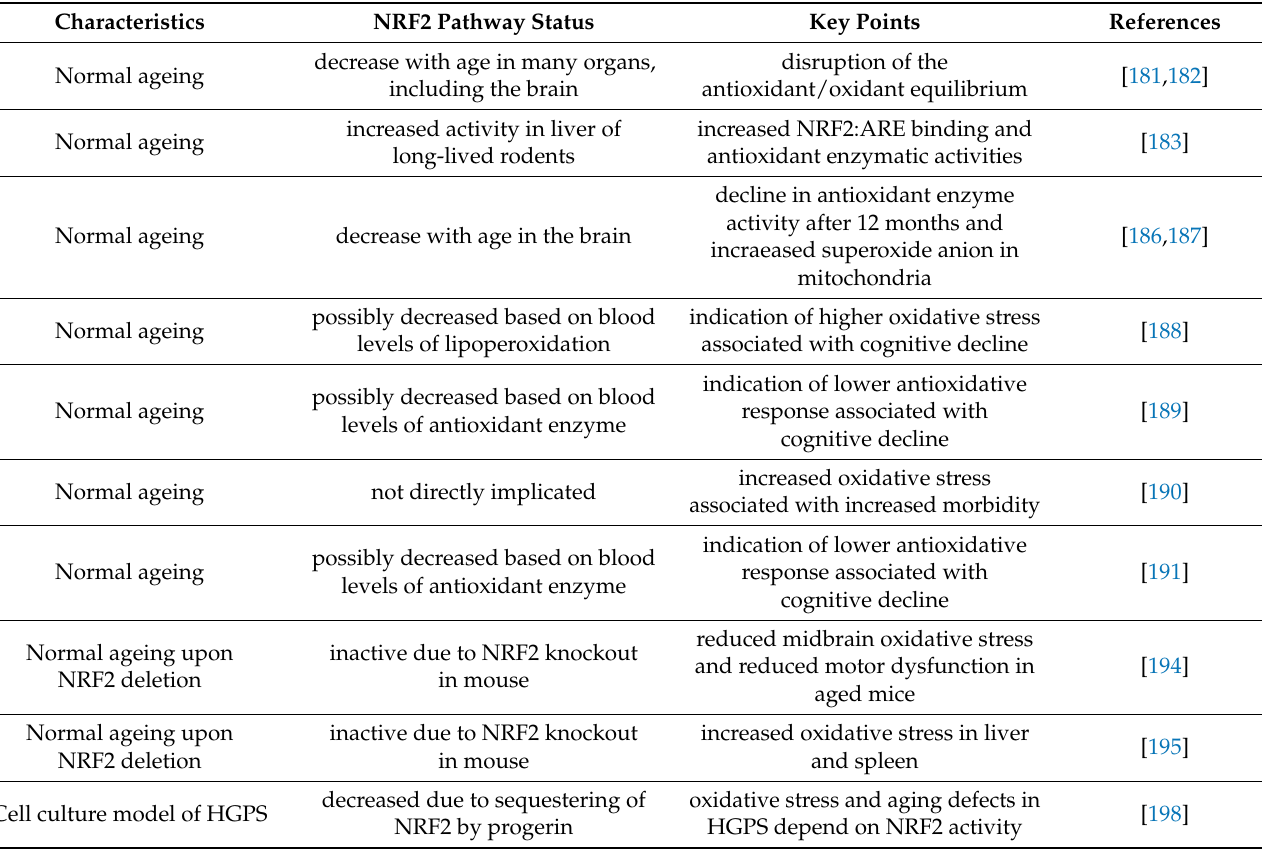
Table 3. NRF2 and